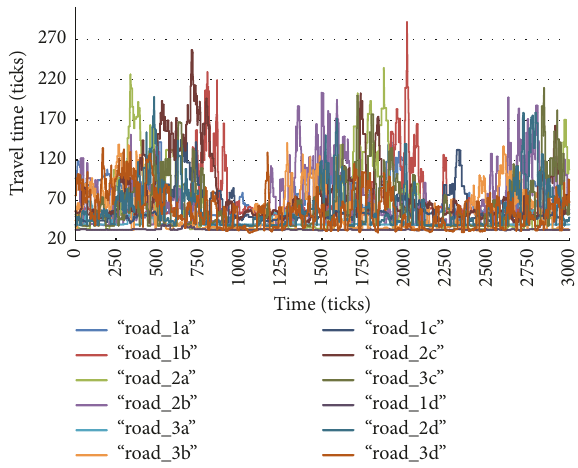
Figure 6: Time-dependent change of travel time under the tradi- tional driving environment.